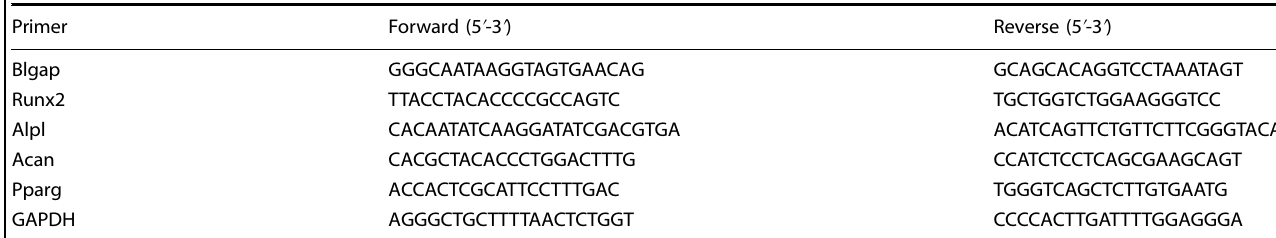
Table 1. All primer sequences used for PCR Primer Forward (5 ʹ -3 ʹ